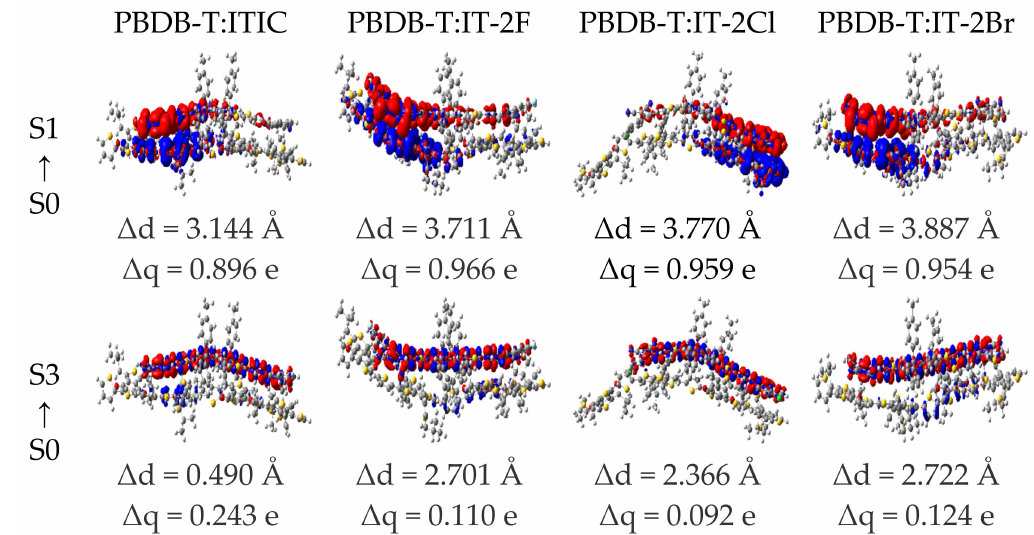
Figure 7. Charge density difference for the low-lying excited states of PBDB-T:ITIC and PBDB-T:IT-2X (X = F, Cl, Br) complexes. The regions colored in red (blue) indicate the increase (decrease) of electron density during excitation processes, respectively. The charge transfer distance ∆ d and the transferred charges ∆ q are shown. (LC-PBE/6-31G**, ω = 0.155, 0.167, 0.144, 0.155 Bohr